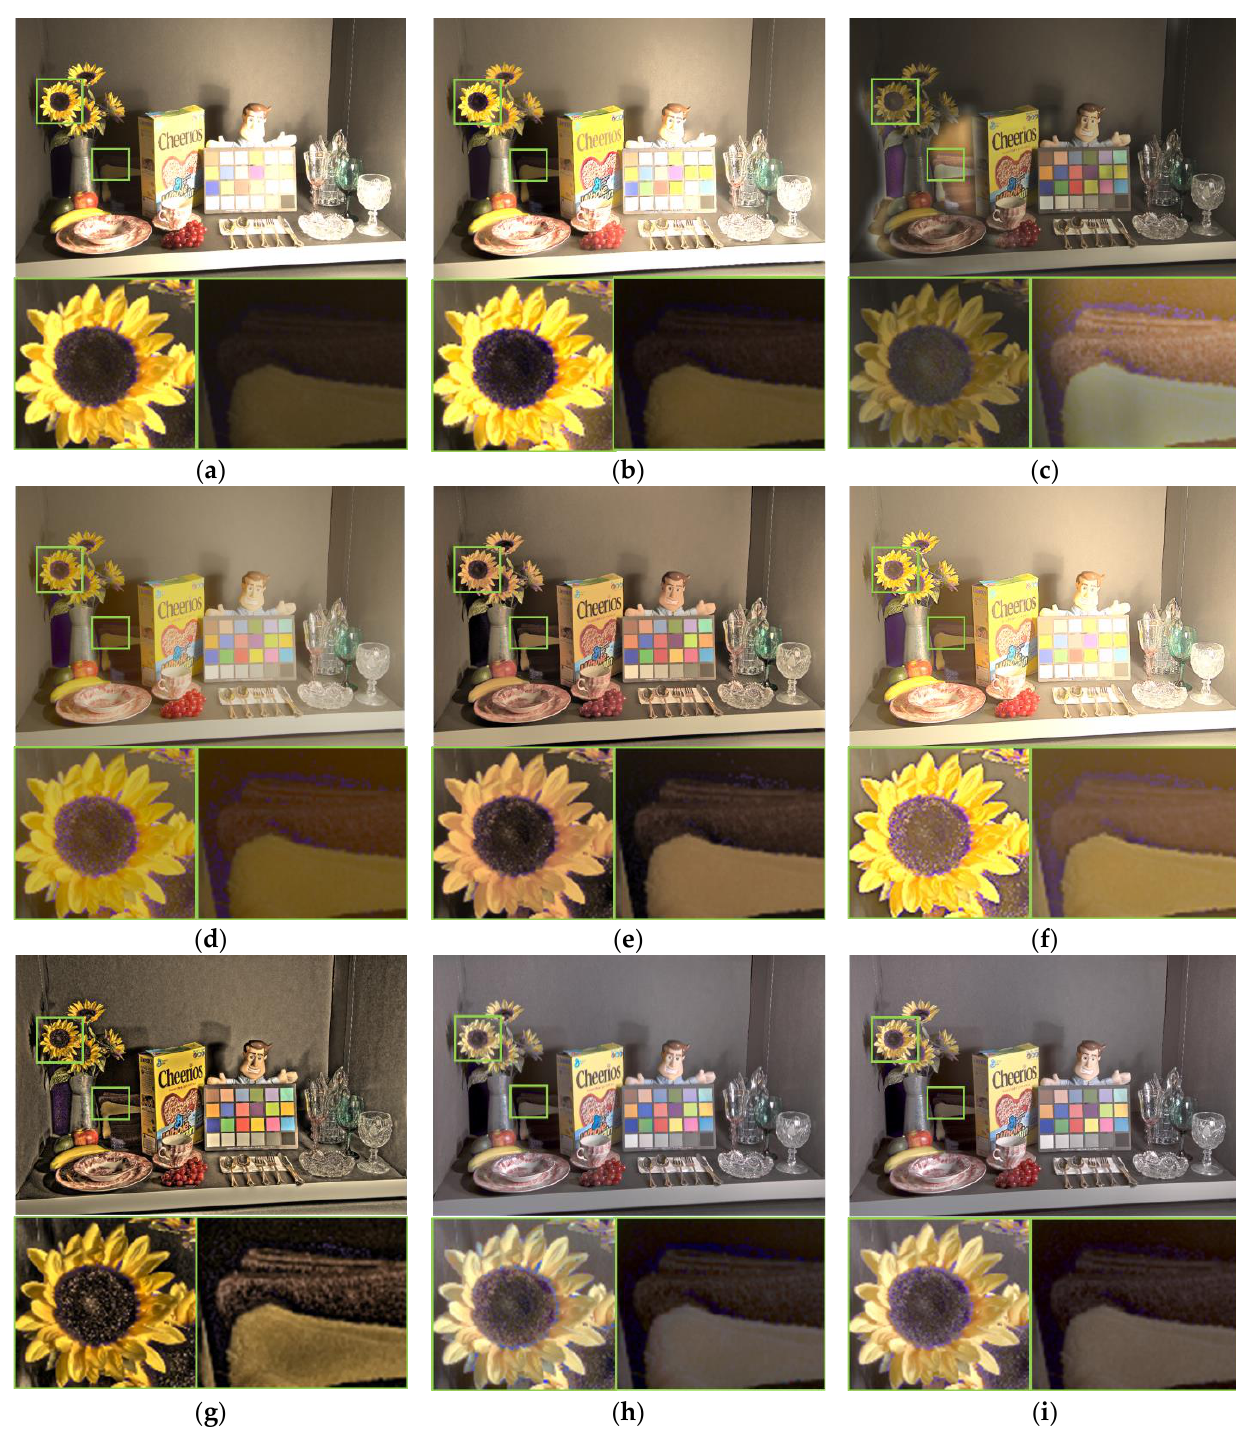
Figure 8. Rendering results of each method for HDR scene #1; ( a ) input image with Gamma tone mapping for visualization; ( b ) Banterle; ( c ) Bruce; ( d ) Reinhard; ( e ) Liang; ( f ) Li; ( g ) Shibata; ( h ) iCAM06; ( i ) proposed method.